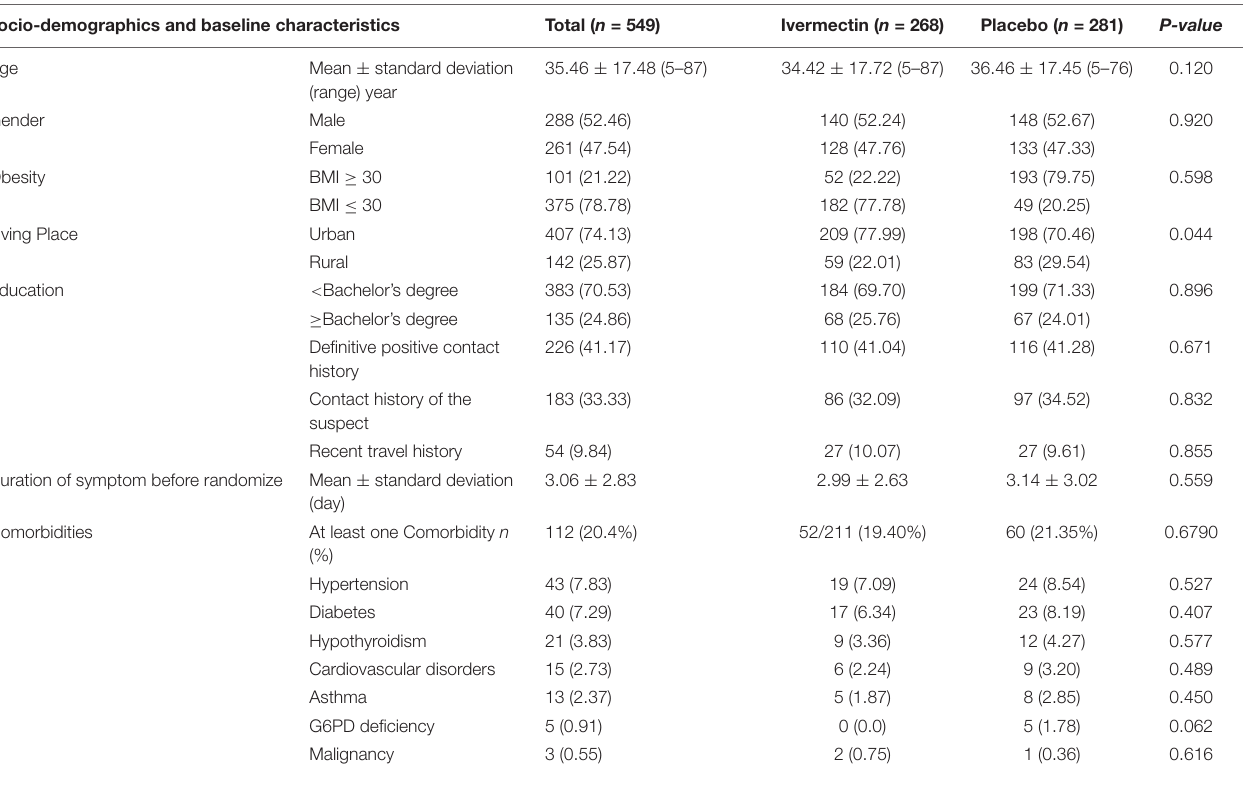
TABLE 4 | The socio-demographics and baseline characteristics of